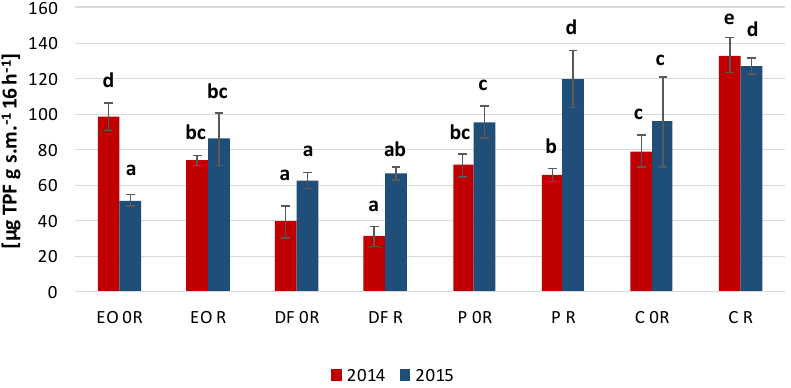
Figure 3. Dehydrogenase activity after four (2014) and five (2015) years from soil contamination and the use of ZB-01. Mean values marked with the same letters for each year separately do not differ significantly according to the LSD test at p < 0.05. Symbols are the same as those used in Figure 1. Vertical bars show mean ± SE.